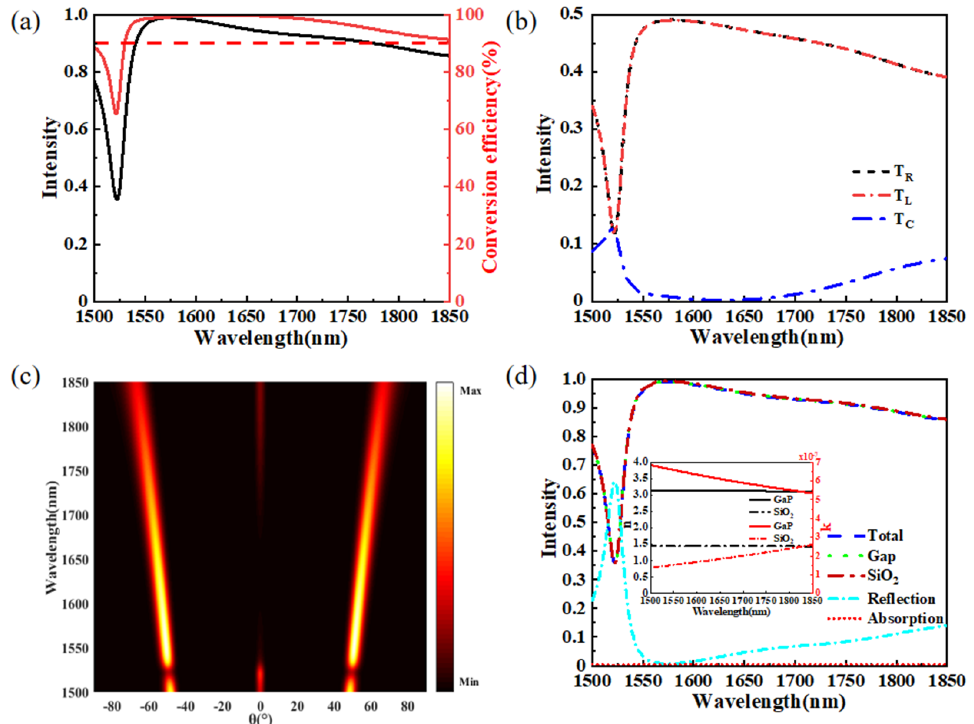
Figure 3. ( a ) Total transmission intensity and conversion efficiency. ( b ) The intensities of T L , T R , and T C in the range of 1500-1850 nm. ( c ) The relationship between the intensity and transmission angle of the diffraction orders in the 1500-1850 nm wavelength range. ( d ) The transmission of each layer and total transmission, reflection, and absorption intensity.